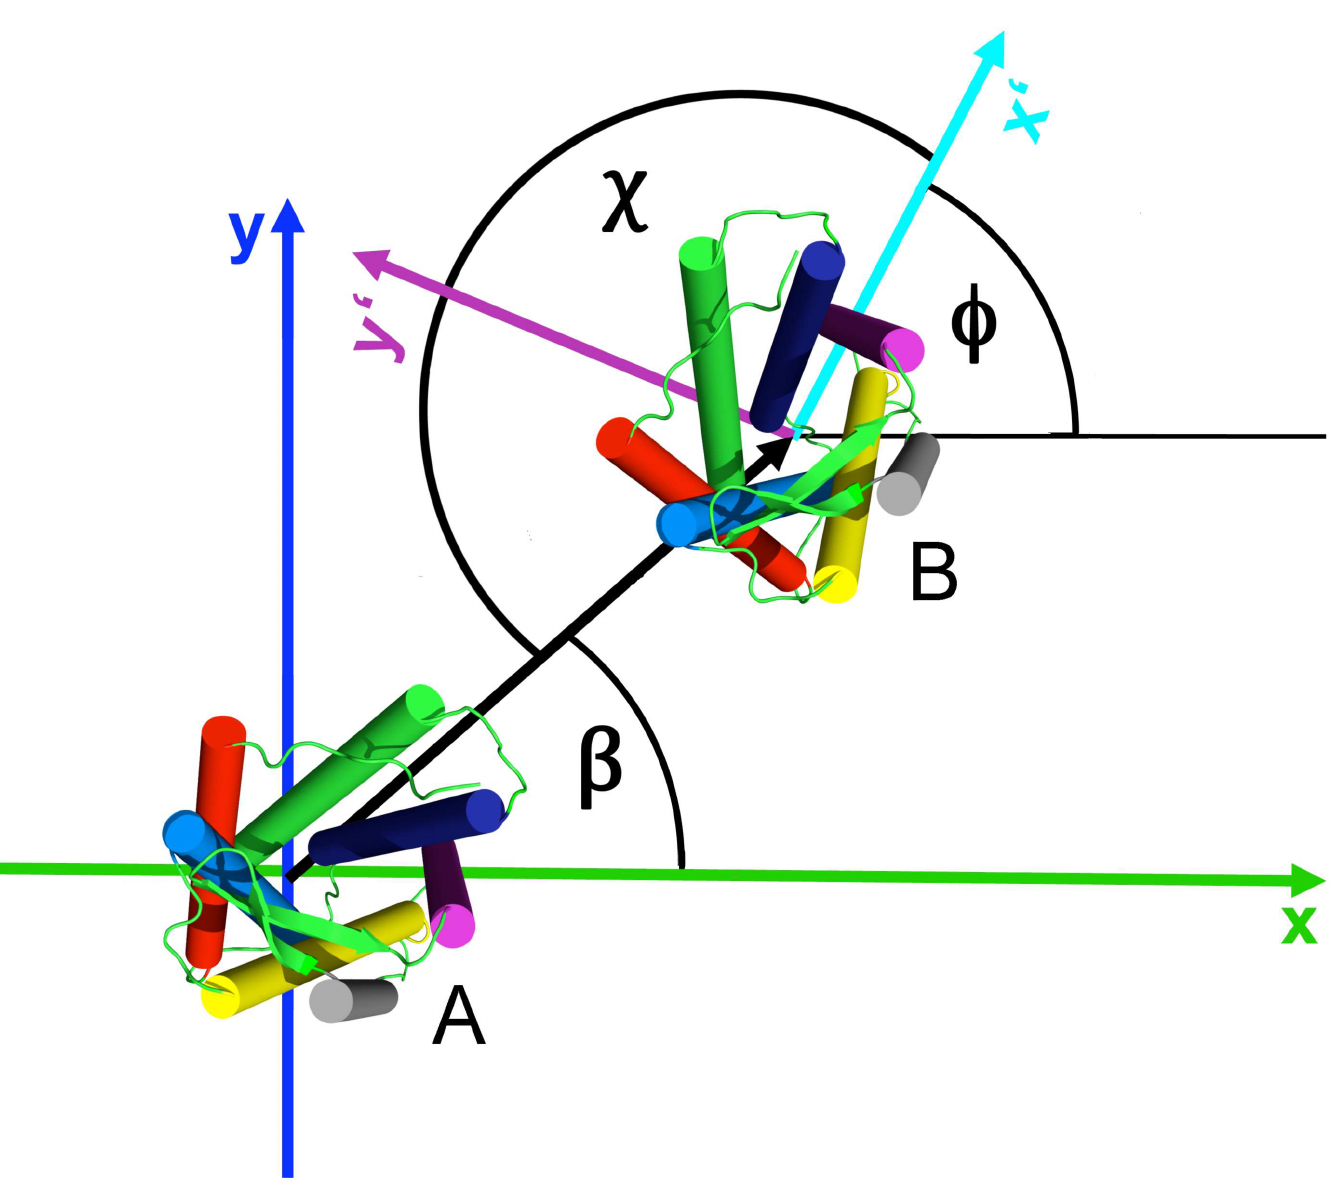
Fig 8. Relative orientation angles used to describe the orientation of the monomers in the receptor dimer. β describesthe position of monomer B with respect to monomer A, φ is the rotation of monomer B around its z-axis, χ the angle under which monomer B “sees” monomer A. The axes x and y were placed into the monomer in a way that the symmetric TM5,6/TM5,6 dimer results in β = 0 and χ =